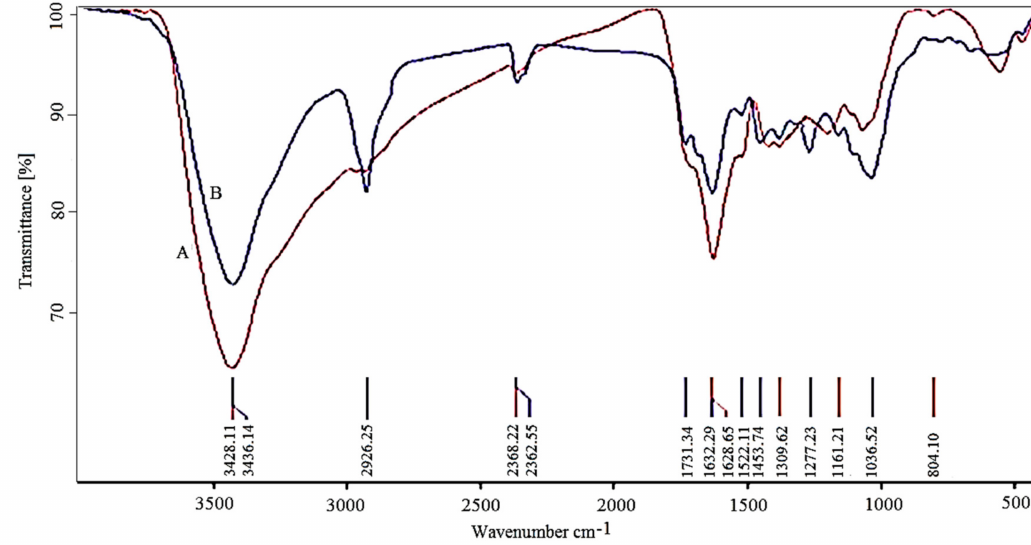
Figure 4. Fourier transform infrared spectroscopy (FTIR) spectrum for the Rosmarinus officinalis extracts before (A) and after (B) biosynthesis of iron oxide nanoparticles.